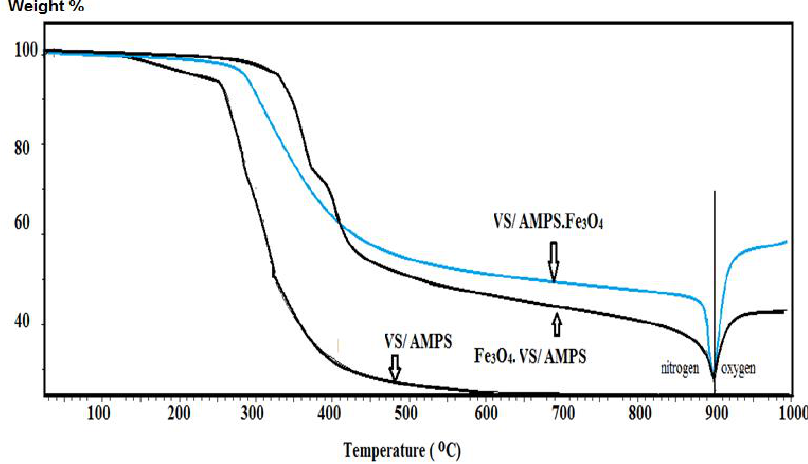
Figure 4. Thermogravimetric analysis (TGA) thermograms of VS/AMPS cryogel and its magnetite composites.